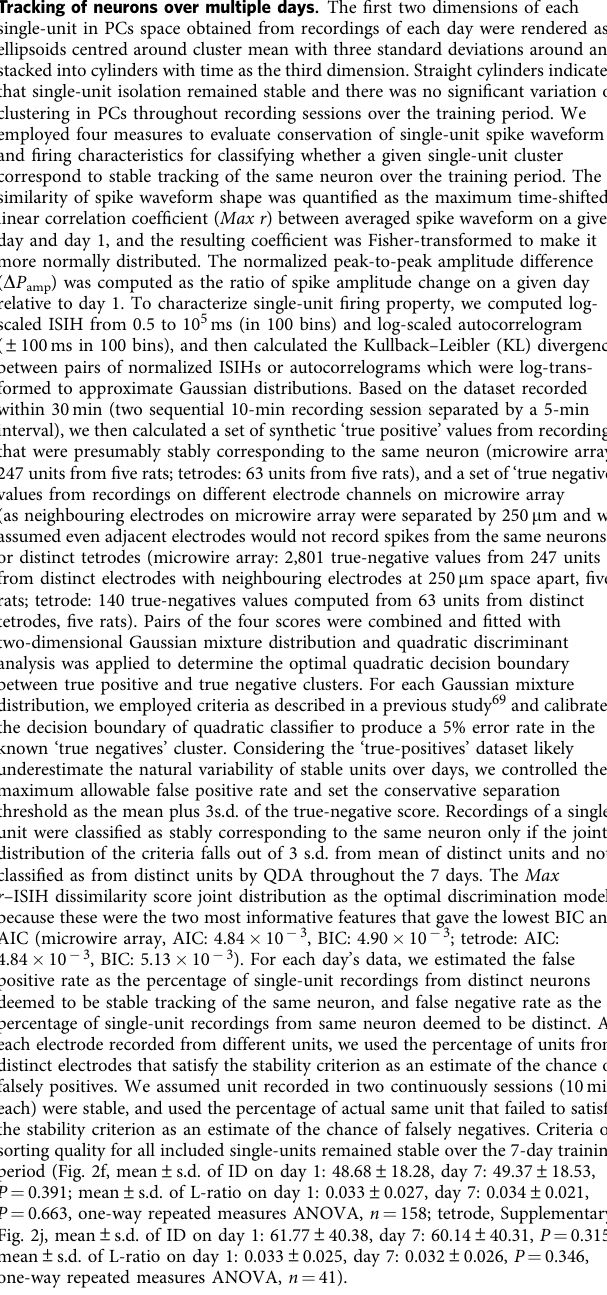
Fig. 2j, mean ± s.d. of ID on day 1: 61.77 ± 40.38, day 7: 60.14 ± 40.31, P ¼ 0.315; mean ± s.d. of L-ratio on day 1: 0.033 ± 0.025, day 7: 0.032 ± 0.026, P ¼ 0.346, one-way repeated measures ANOVA, n ¼